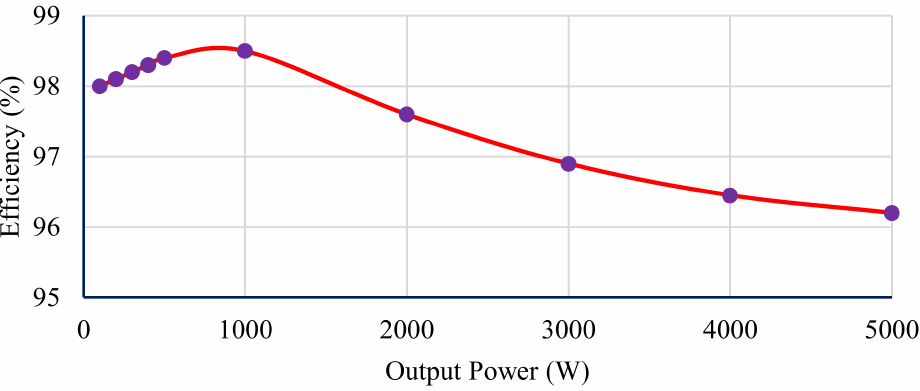
Figure 5. Efficiency plot of the proposed